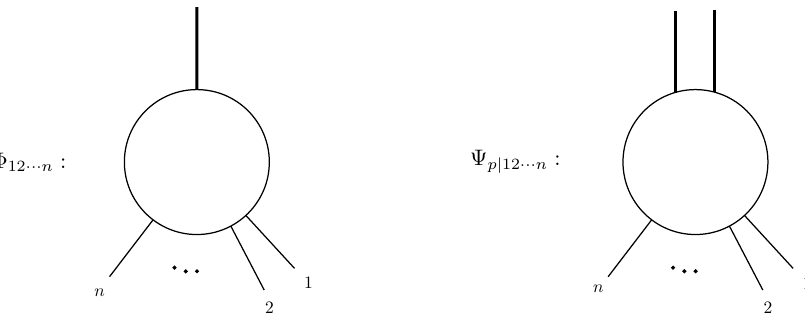
Figure 1 . Graphical representation of the off-shell currents. The thick lines denote the off-shell